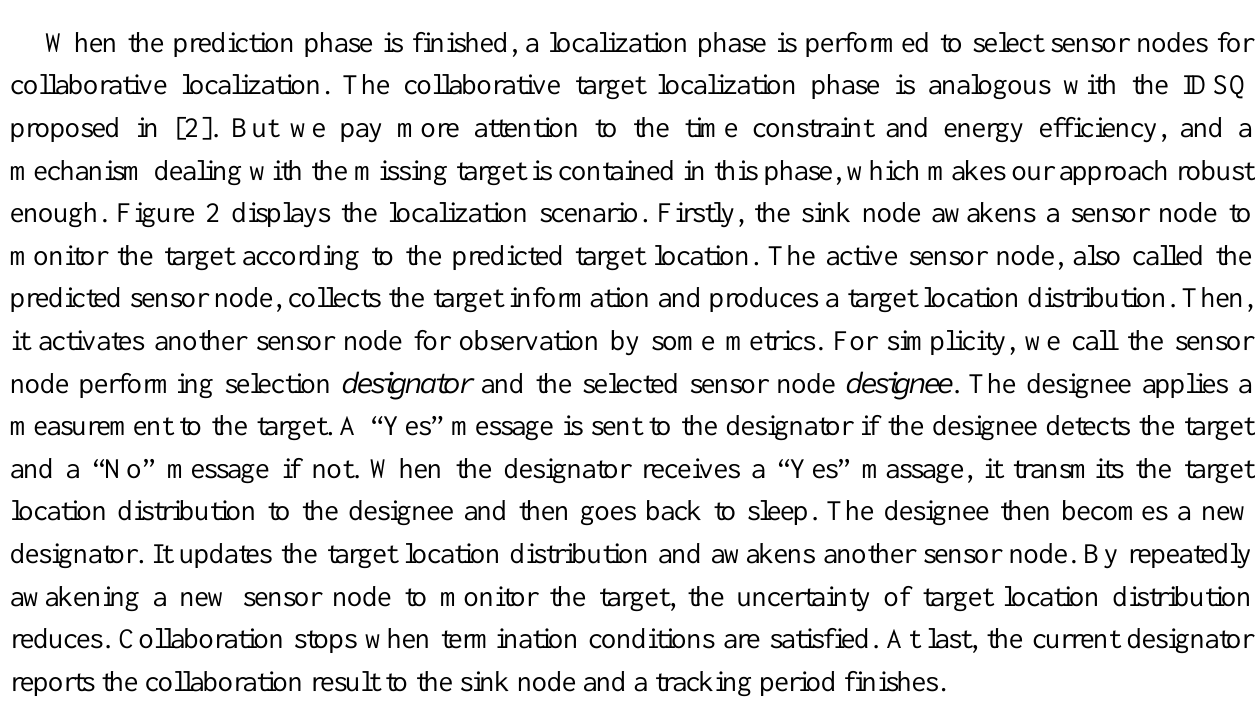
Figure 2 . Collaborative target localization